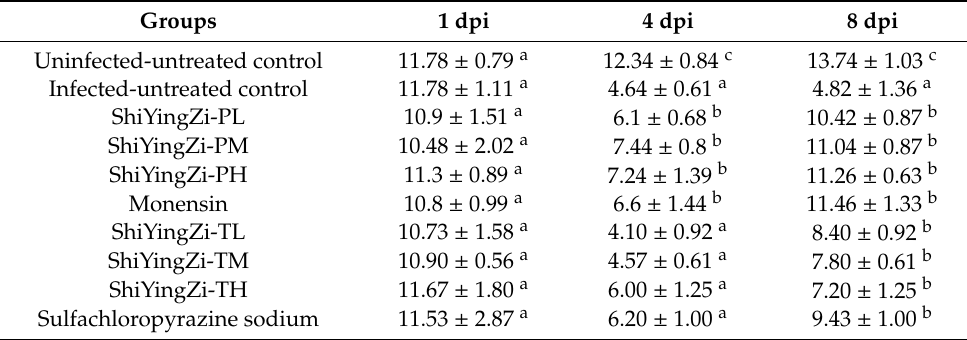
Table 6. The albumin content (g /